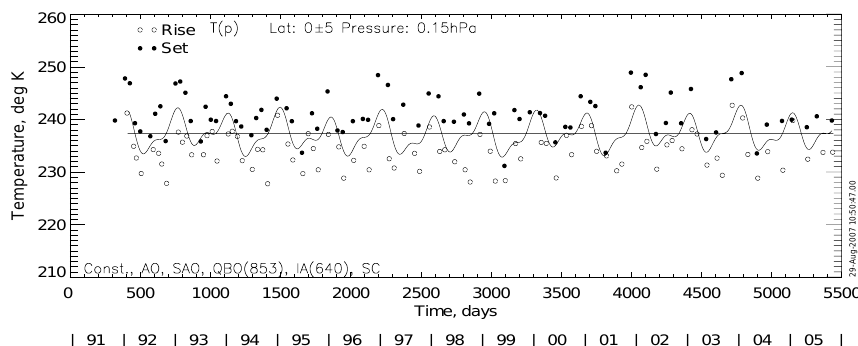
Fig. 1. Time series of zonal average SS (solid circles) and SR (open circles) temperatures (K) from HALOE measurements at the equator and the 0.15-hPa level of the mesosphere (near 62km). Terms for the multiple linear regression (MLR) model fit are listed at the lower left. The oscillating curve is the fit for the complete MLR model, while the straight line is the value of the constant term.